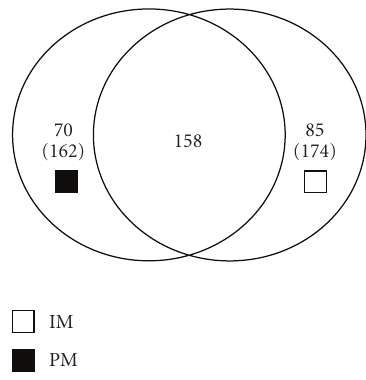
Figure 2: Venn diagram presenting the number of total plasma proteins identified with two or more peptides (in brackets, with one peptide) after immunoa ffi nity depletion of high-abundant proteins (IM), hexapeptide ligand library treatment (PM) or both prefractionation methods.